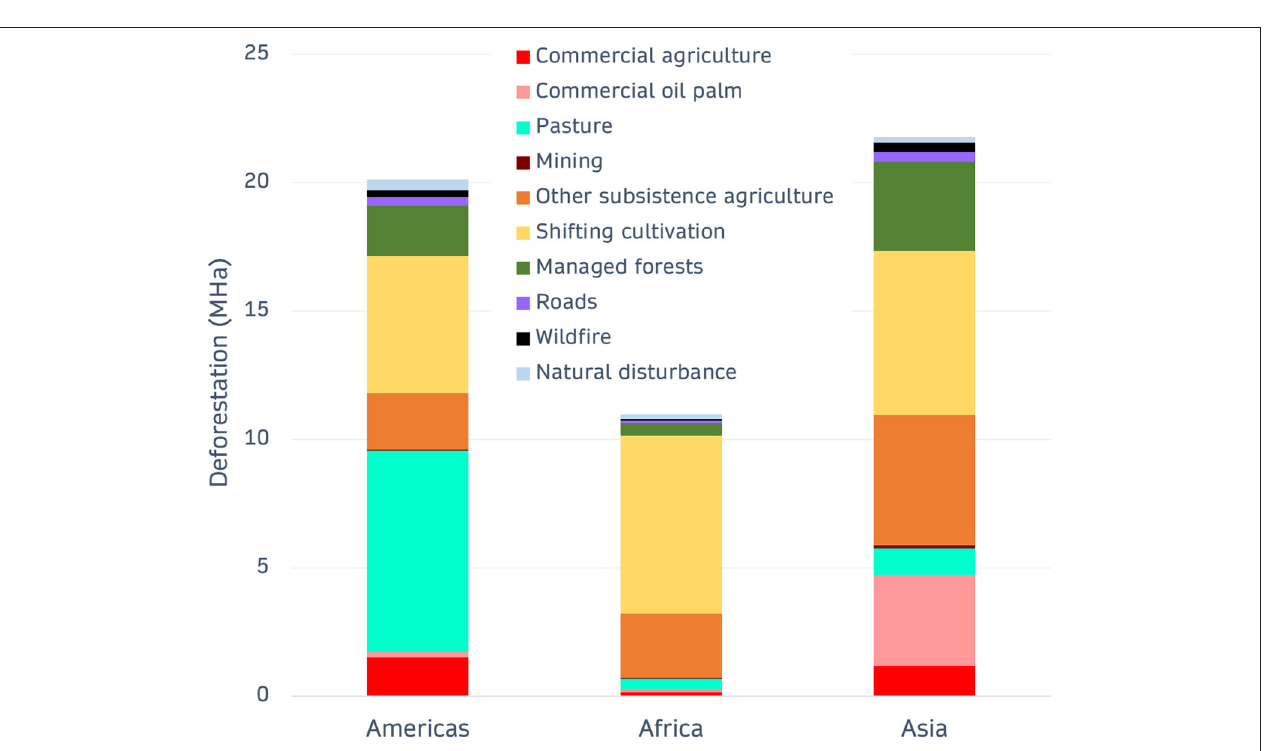
lower deforestation rates in strictly protected areas compared to non-strictly protected areas although they represent the most important drivers in protected areas overall. What is even